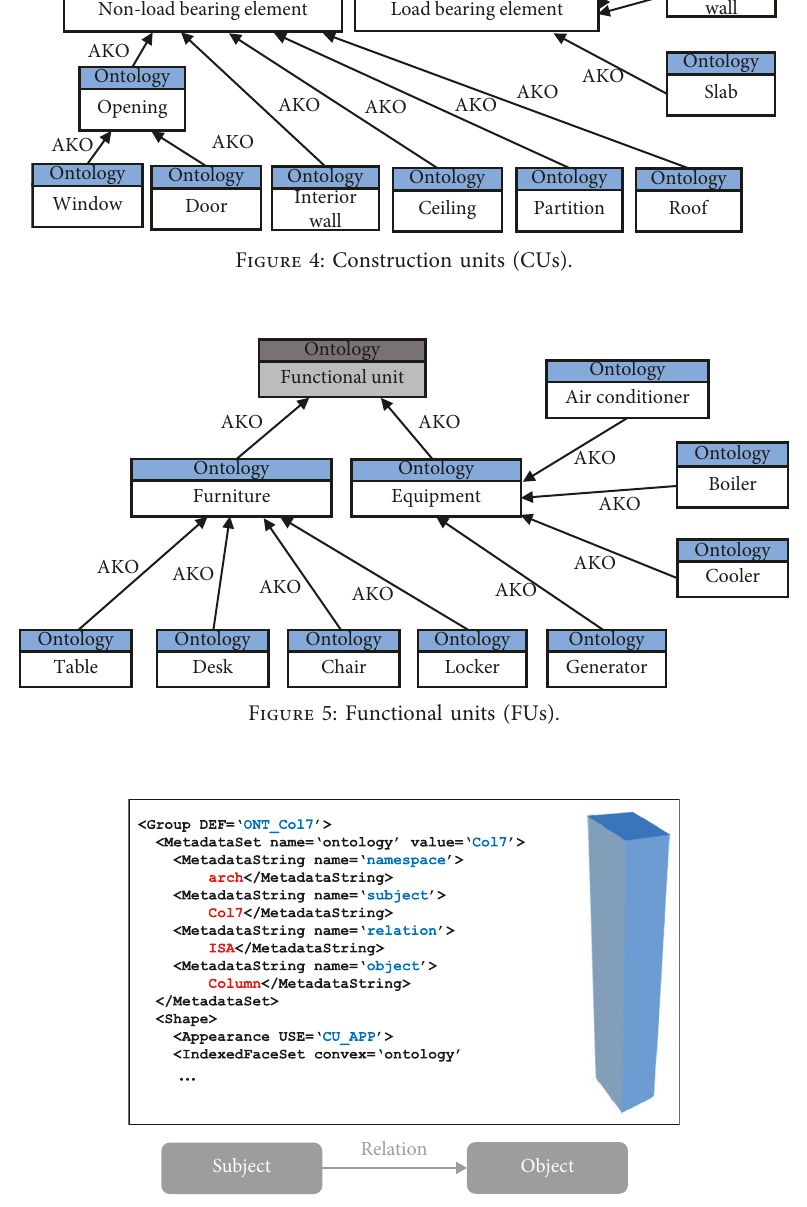
Figure 6: Ontology-based design process model and design expressed by an ontology and RDF triple based on the graph model in [22,